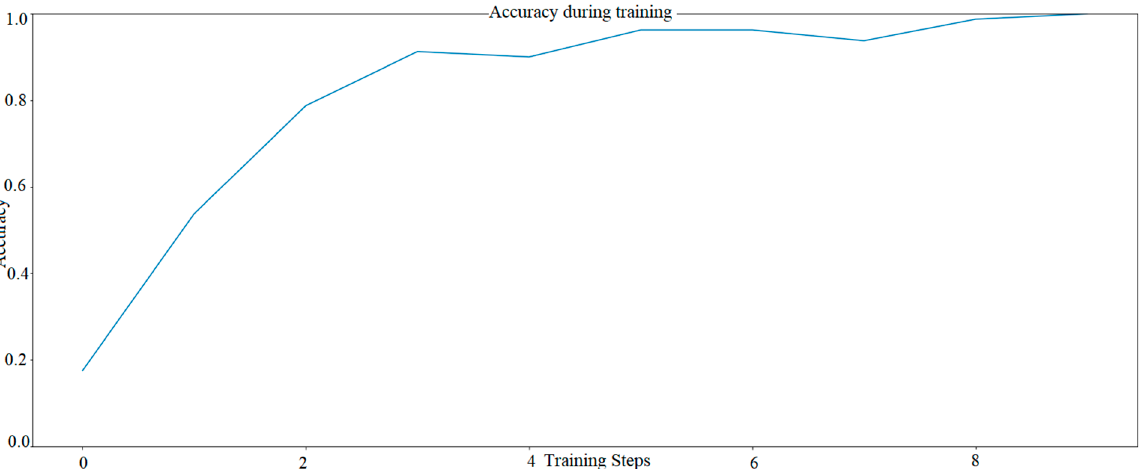
Figure 5. The learning progress of AI model with several solutions proposed by Siemens—Model two AI. The graph was developed based on TensorFlow library.